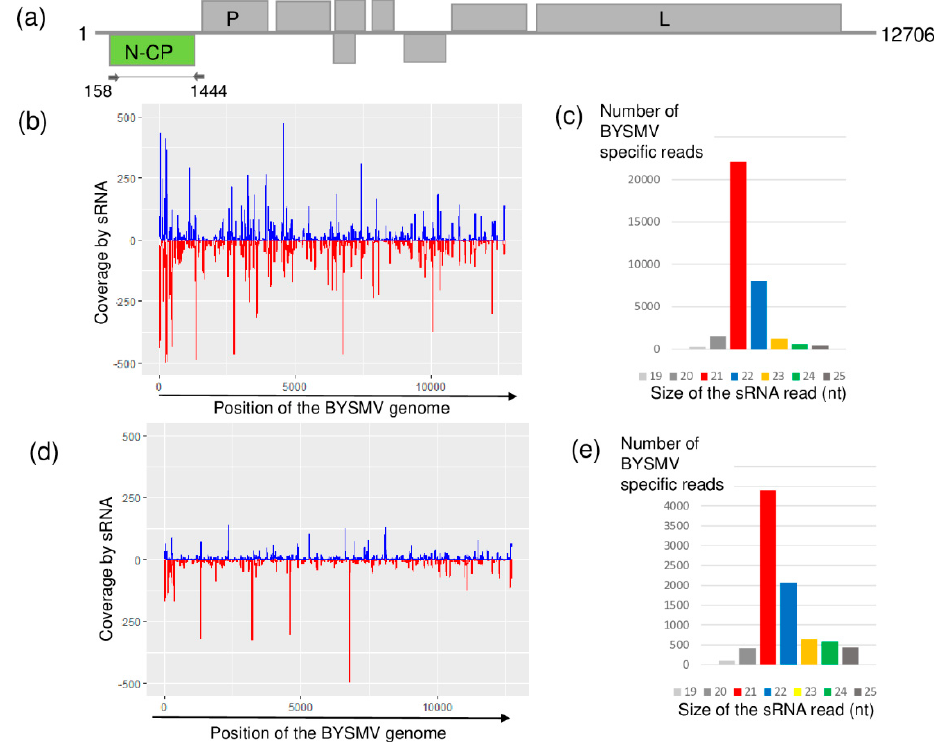
Figure 3. Results of the barley yellow striate mosaic virus (BYSMV) detection by sRNA HTS. ( a ) Genome organization of BYSMV, highlighting its coding regions and the position of the primers that were used in the RT-PCR. ( b ) and ( d ) show coverage of the genome by the sequenced virus-specific sRNA reads at Budos-arok (BA) and Ujmajor-susnyas (US), respectively. The blue color shows sRNA in sense, while the red color shows sRNAs in antisense orientation. ( c ) and ( e ) show the size distribution of the sequenced, BYSMV-specific sRNA reads at BA and US, respectively.